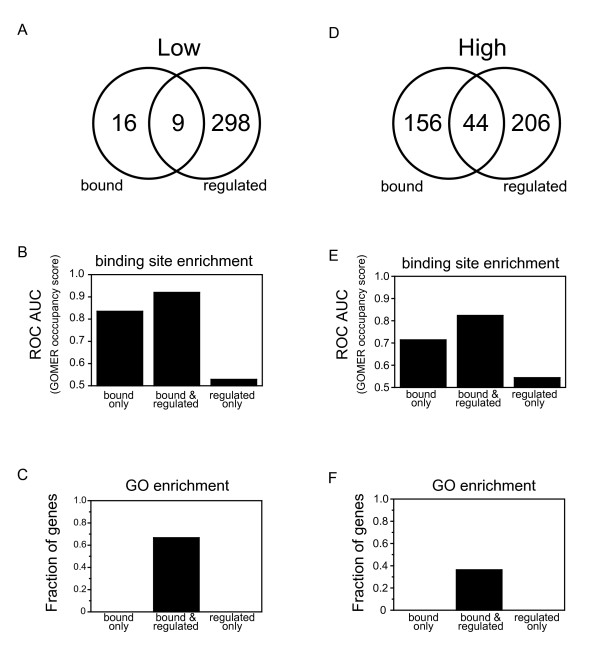
Comparison of chromatin immunoprecipitation and transcriptome data at low and high Leu3 activity. (A) Venn diagram showing the number of genes bound and/or regulated at low concentrations. (B) Association of Leu3 binding sites with the indicated subset of genes defined as bound and/or regulated at low concentrations. All genes were scored for predicted Leu3 binding potential using GOMER [8], and ranked according to this score. Genes in the indicated subset were compared to all other genes in the genome using a receiver operator characteristic curve (ROC), and the value of the area under the curve is shown in this histogram. The histogram starts at a value of 0.5 because that is the value expected by chance. A value of 1.0 would indicate that the predicted binding potential scores perfectly discriminate the experimentally defined subset of genes from all others. (C) The fraction of genes in each low concentration subset that have Gene Ontology process annotations that are significantly enriched (P ≤ 1e-6). Gene ontology analyses were performed using the Saccharomyces Genome Database web site [21]. (D–F) These panels are analogous to panels A–C except that the genes were defined based on experiments using constitutively active protein expressed at higher-than-endogenous levels.